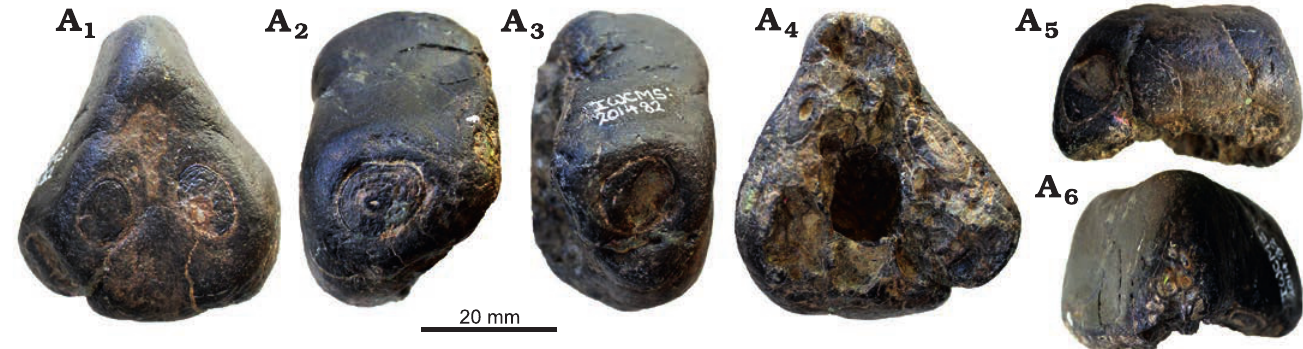
Fig. 5. Anhanguerid pterosaur Uktenadactylus rodriguesae sp. nov., IWCMS 2014.82, Sudmoor Point, Isle of Wight, England, Barremian. In anterior (A 1 ), left (A 2 ) and right (A 3 ) lateral, posterior (A 4 ), and palatal (A 5 ) views. Photographs by